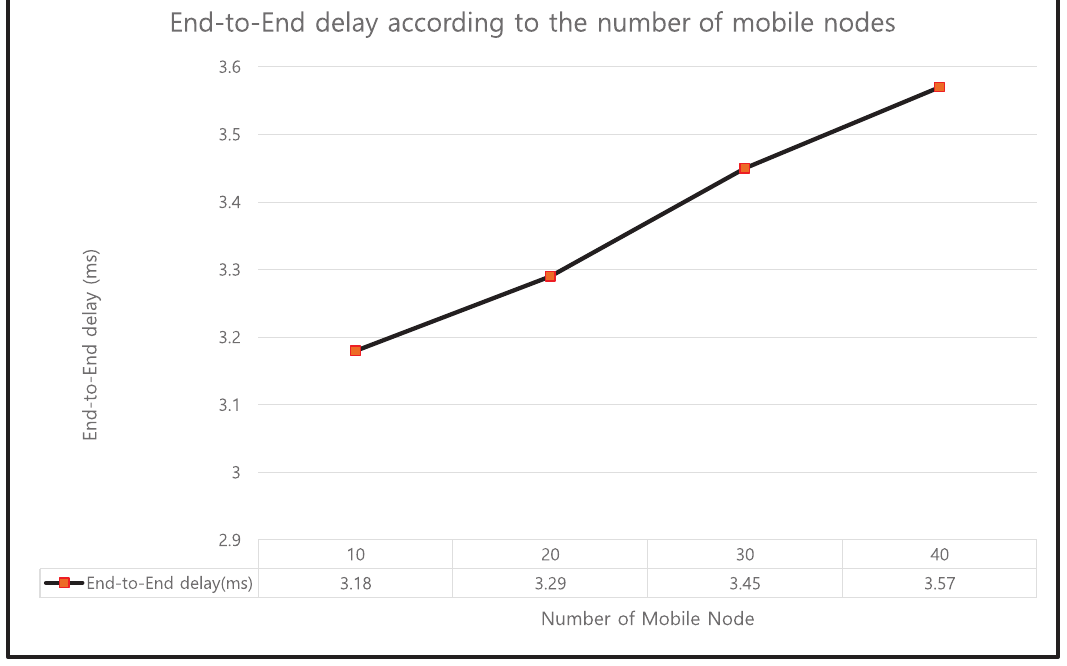
Fig 27. End-to-end delay according to the number of mobile nodes.